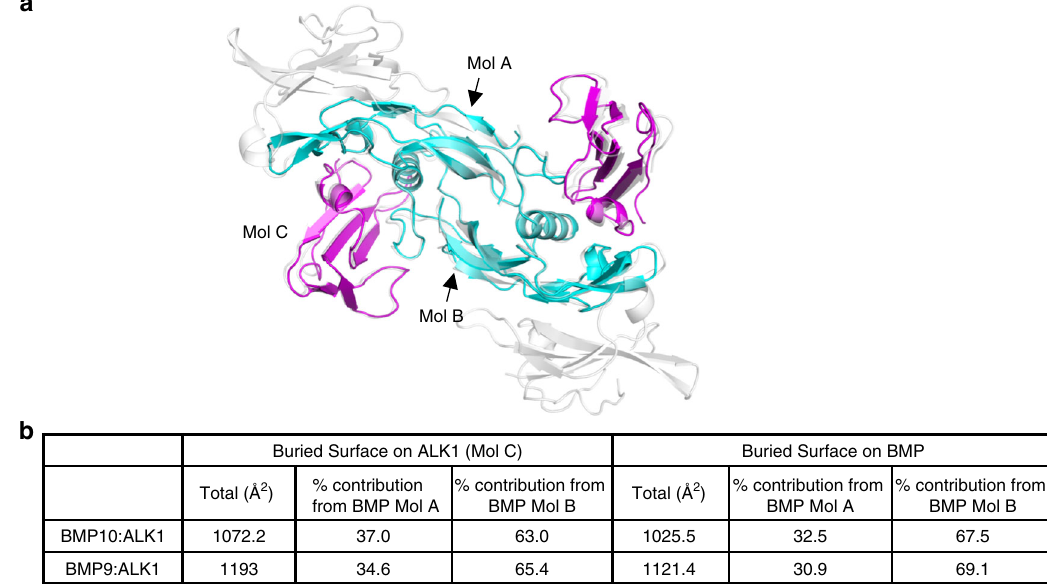
Fig. 2 Crystal structure of human BMP10:ALK1 complex at 2.3 Å. a Crystal structure of BMP10 (cyan) in complex with ALK1 (magenta), overlaid with the structure of BMP9:ALK1:ActRIIb complex (PDB:4FAO, in grey and semi-transparent). Mol A and Mol B are the two BMP monomers whose interfaces with ALK1 (Mol C) were analysed in b . b Comparison of the buried interface upon complex formation between BMP10:ALK1 and BMP9:ALK1 (from 4FAO). Total buried surface area and the contributing residues were calculated using PDBePISA